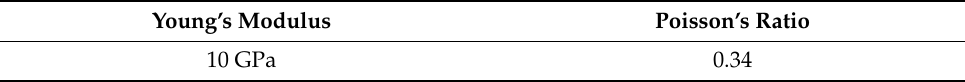
Table 3. Main mechanical properties of the adhesive